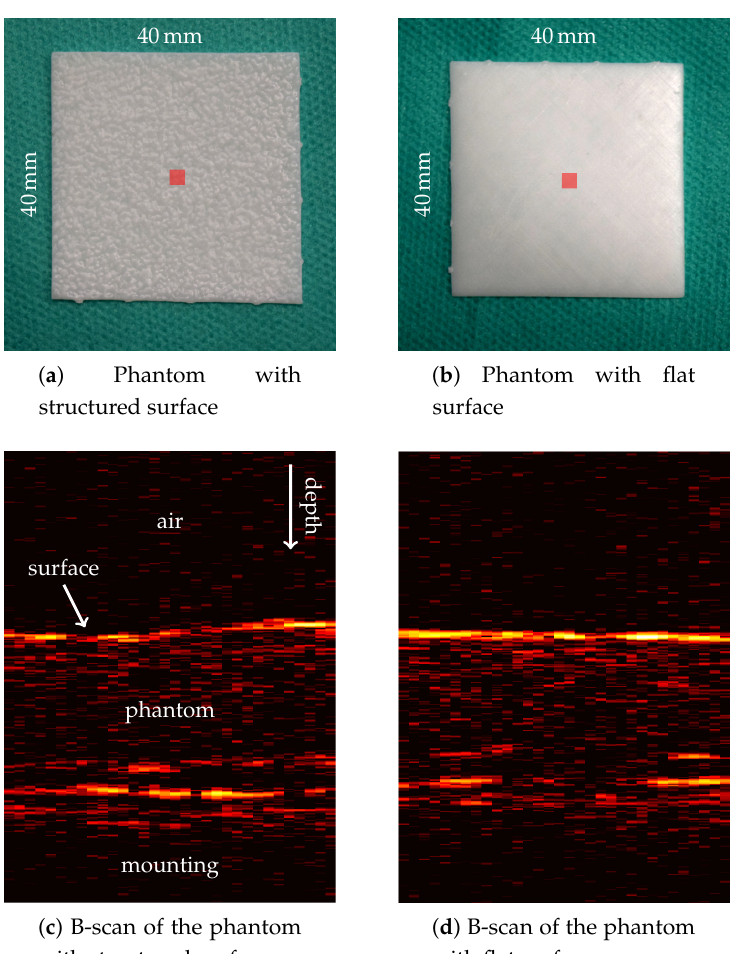
Figure 5. Top row: Pictures of the phantom with a structured surface ( a ) and the phantom with a flat surface ( b ). The backsides of both phantoms are structured too. For comparison, the size of the OCT’s FOV is illustrated as red squares. Bottom row: B-scans of the structured-surface phantom ( c ) and the flat-surface phantom ( d ). Each column corresponds to one A-scan with increasing measurement depth from top to bottom. The B-scans’ pixels are stretched to match their physical dimensions, which are about 2.5mm laterally and 3.5mm in depth direction in